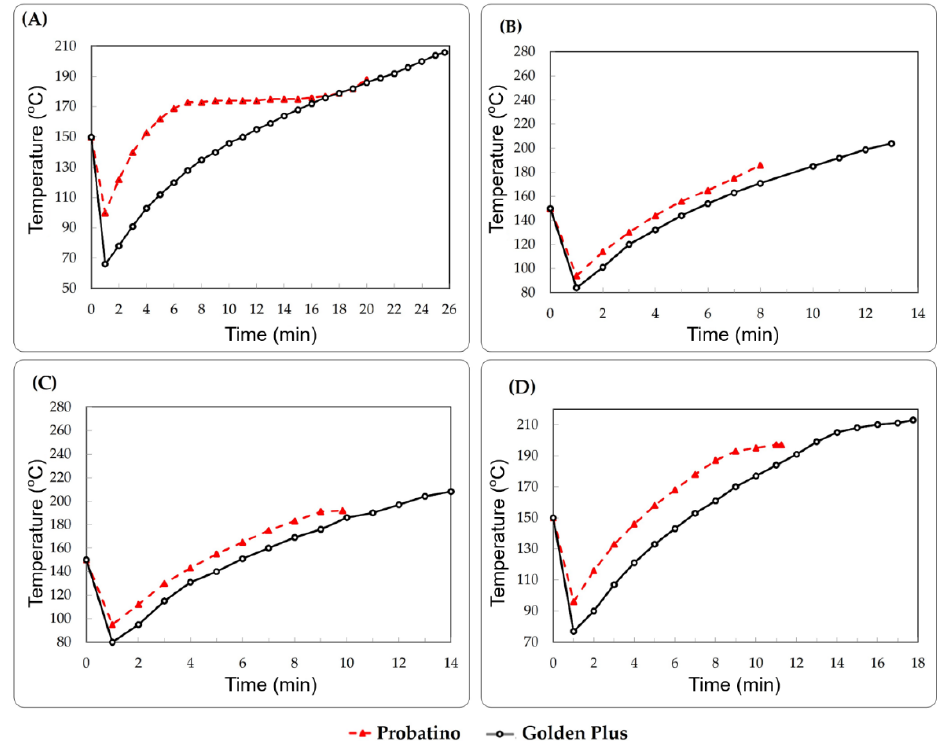
Figure 2. Baked ( A ), light ( B ), medium ( C ), and dark ( D ) roasting curves of coffee beans obtained from Probatino (Probat, Germany) and Golden Plus (Atilla, Brazil) roasters.